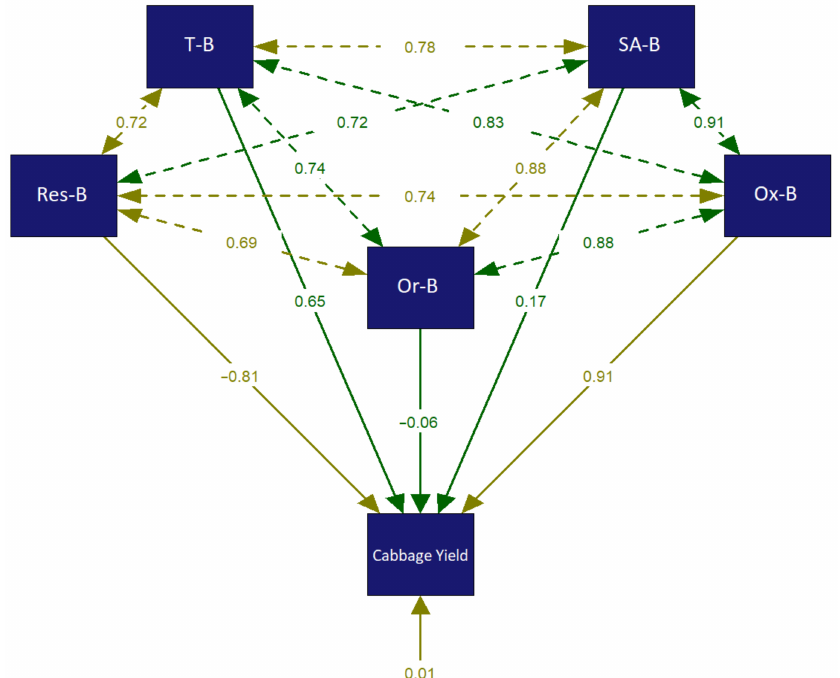
Figure 6. Path diagram and coefficient of factors of different B fractions influencing yield of cabbage. Single head arrows and connector indicate direct effect and natural association,